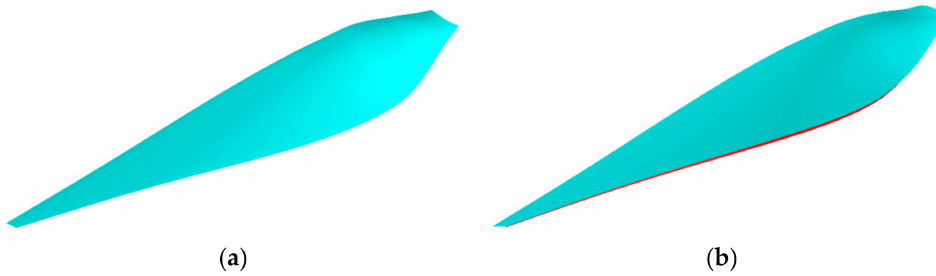
Figure 17. The geometries of the optimized propellers: ( a ) Prop A; ( b ) Prop B.